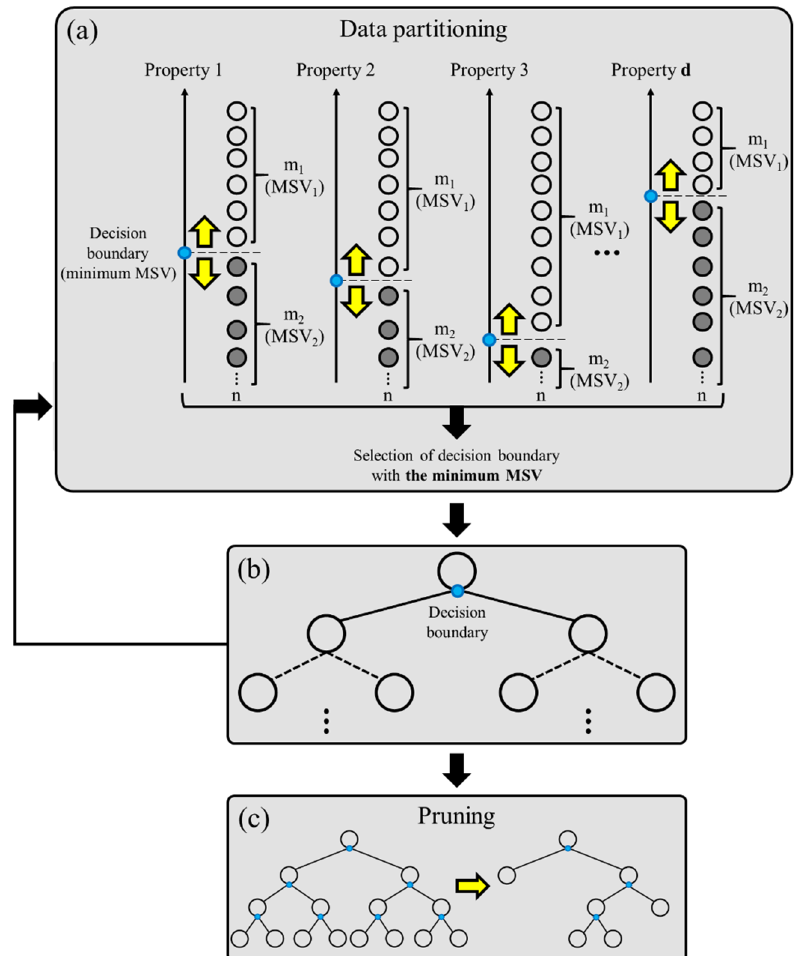
Figure 6. The construction of a decision tree with recursive partitioning and pruning based on n sample data of the d property. ( a ) finding the best decision boundary having the largest purity of data; ( b ) making branches according to proper decision boundaries; ( c ) removal of excessive branches to prevent overfitting.